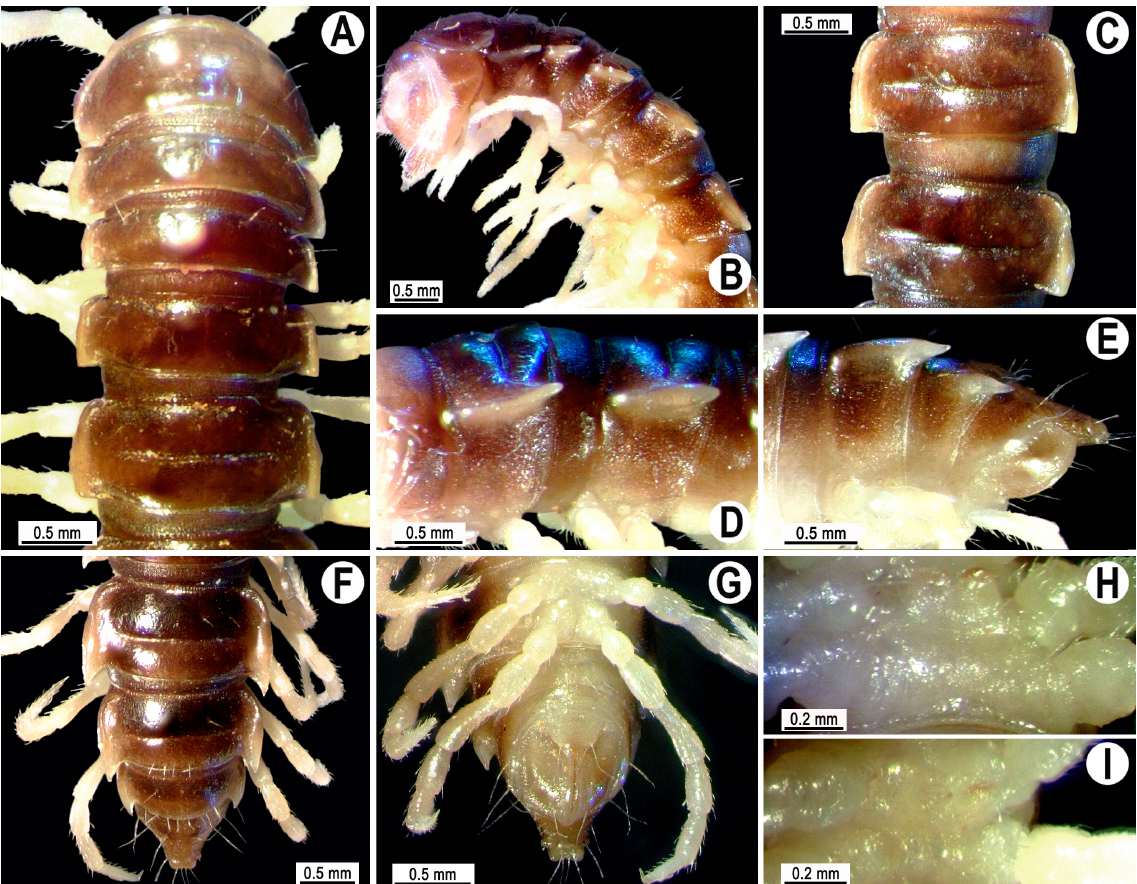
Fig. 21. Tylopus punctus sp. nov., holotype, ♂. A–B . anterior part of body, dorsal and lateral views, respectively. C–D . Segments 11–12, dorsal and lateral views, respectively. E–G . Posterior part of body, lateral, subdorsal and subventral views, respectively. H–I . Sternal cones between coxae 4, subcaudal and sublateral views,